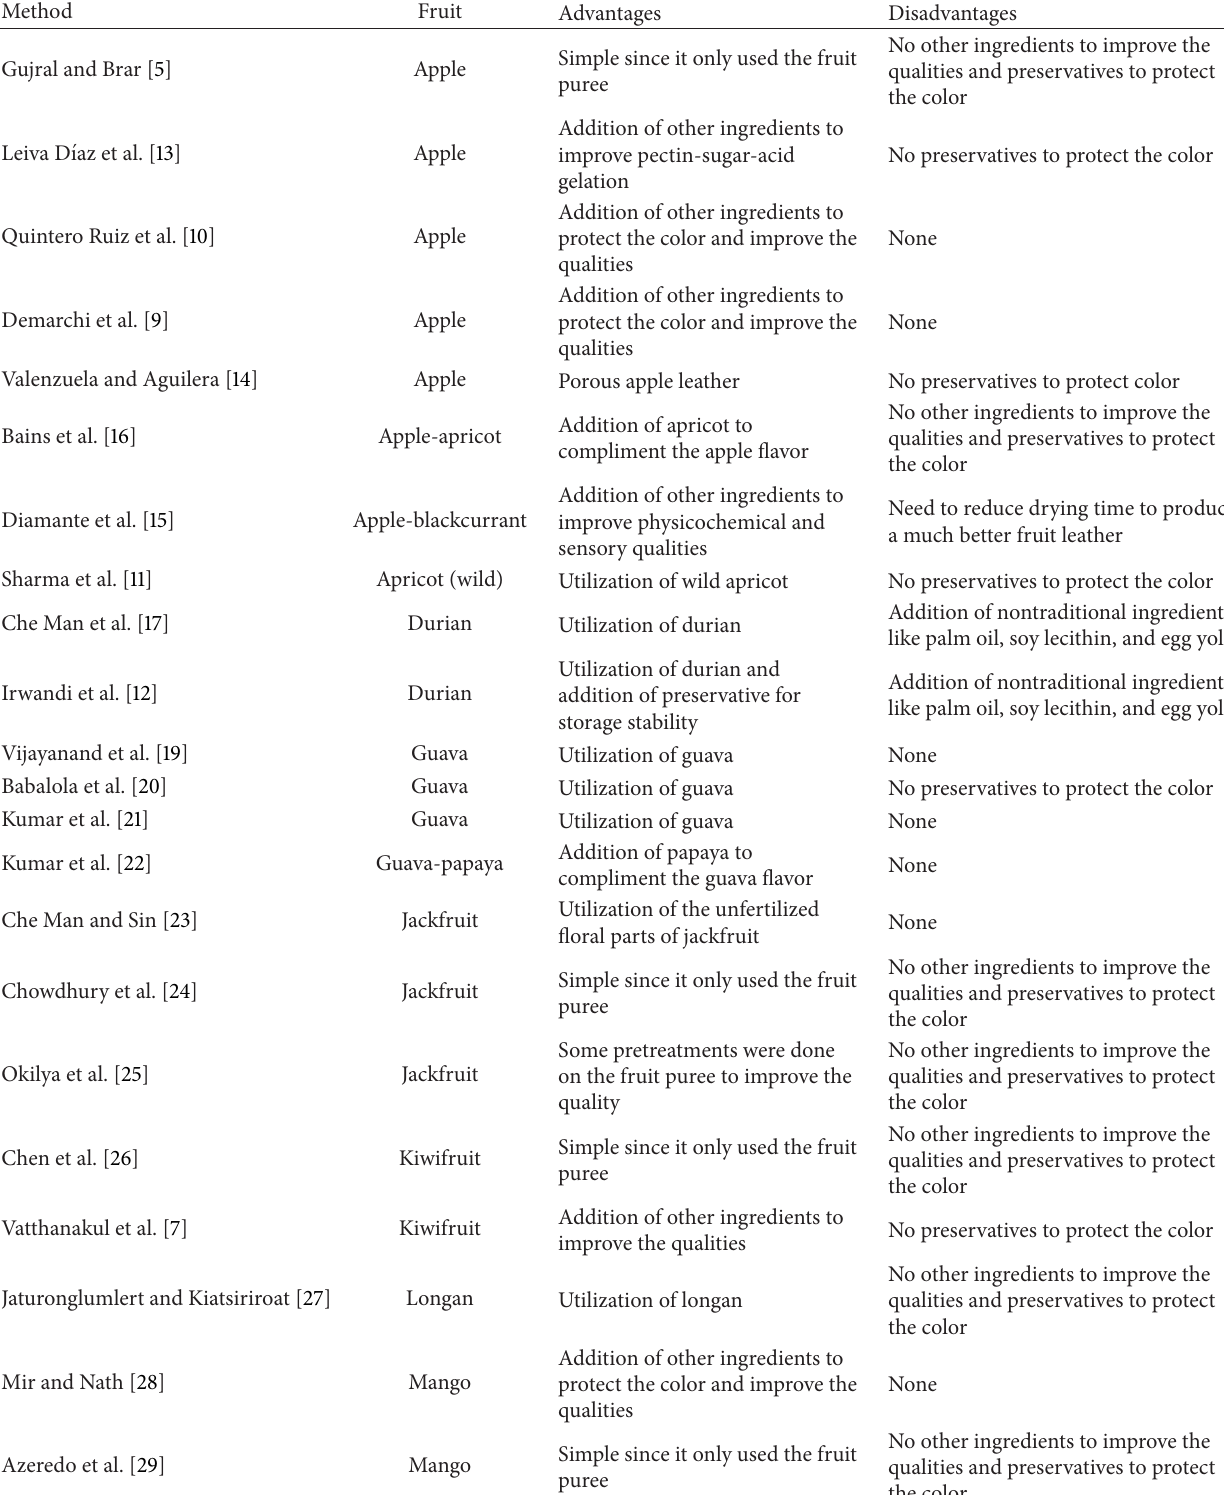
Table 1: Advantages and disadvantages of the method of preparation for the different fruit